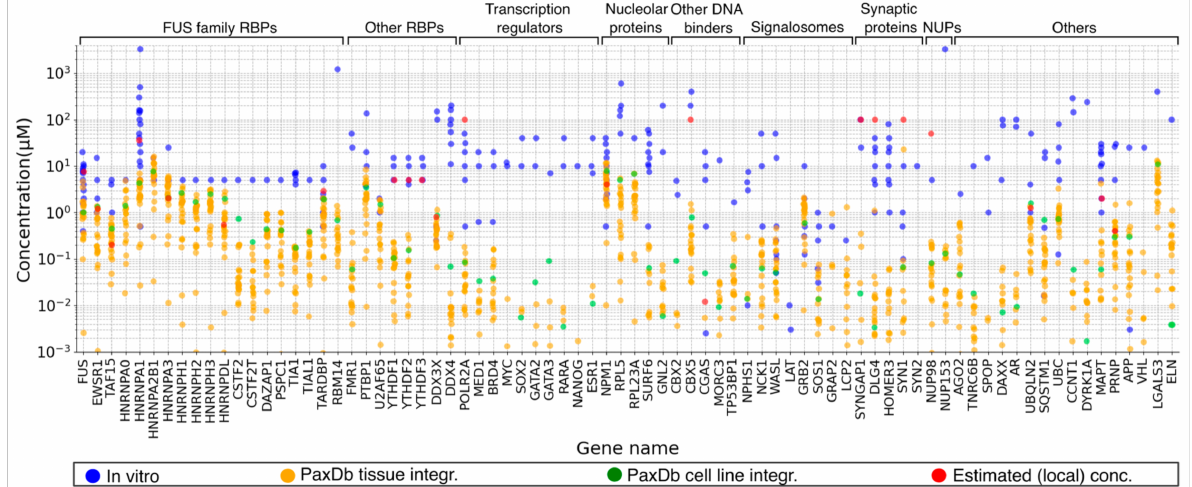
Figure 3. Protein concentrations applied in in vitro LLPS experiments frequently exceed those calculated from proteomics- derived cellular protein abundances. Comparison of protein concentrations used in in vitro LLPS experiments (in blue), concentrations calculated from proteomics-derived cellular protein abundances stored in the PaxDb database (tissue-specific integrated values in orange and cell-line integrated values in green), and local concentrations estimated or referred to by authors (in red) for human LLPS driver proteins integrated from the three LLPS resources and filtered for in vitro verified true LLPS (co)drivers. Concentrations are provided in micromolar units, while LLPS proteins are represented by the respective gene names on the horizontal axis. Functional groups of the proteins are indicated on the top of the figure. For the products of genes LAT , SYN2 , and YTHDF3 , PaxDb concentration values were not